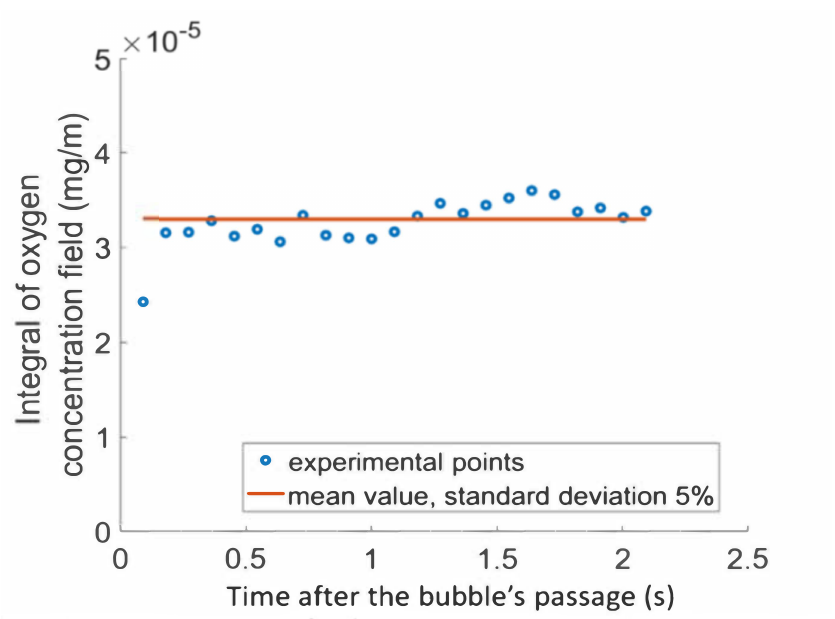
Figure 5. Integral of the oxygen concentration field according to the time after the bubble’s passage in solution of PAAm and Triton X-100.